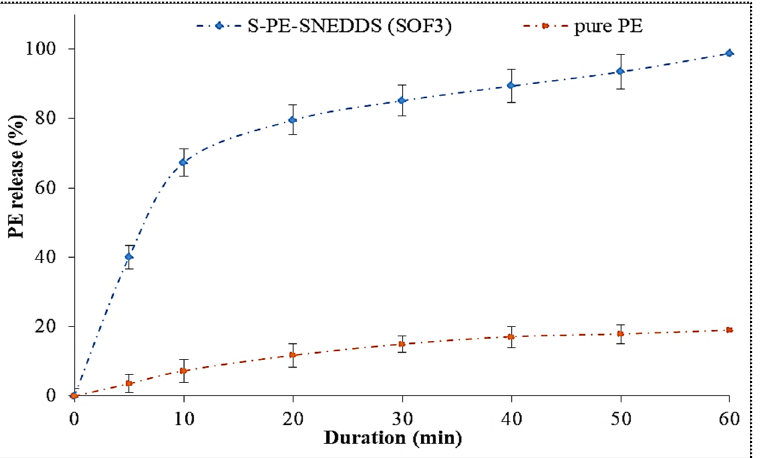
Figure 8. Comparative dissolution study of S - PE-SNEDDS (SOF3) and pure PE dispersion. Values are given as mean ± SD ( n = 3).